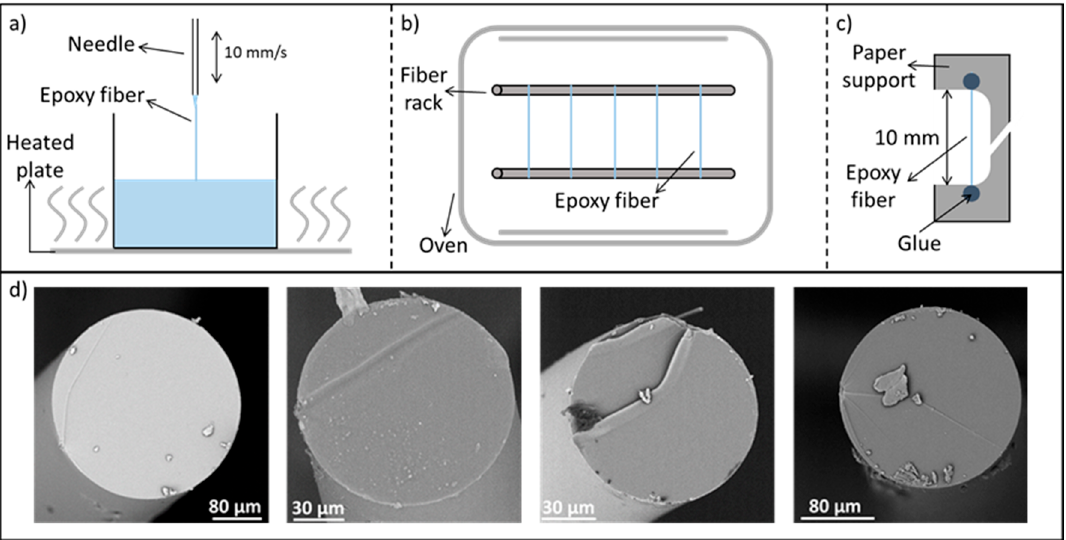
Figure 2. Production method. ( a ) Epoxy fibers are drawn from the vitrifying resin. ( b ) The produced fibers are cured at 80 °C in an oven for 15h. ( c ) The final fibers are glued on paper supports for single fiber tensile testing. ( d ) Cross-sections of several produced microfibers after fracture, showing a perfect circular shape.